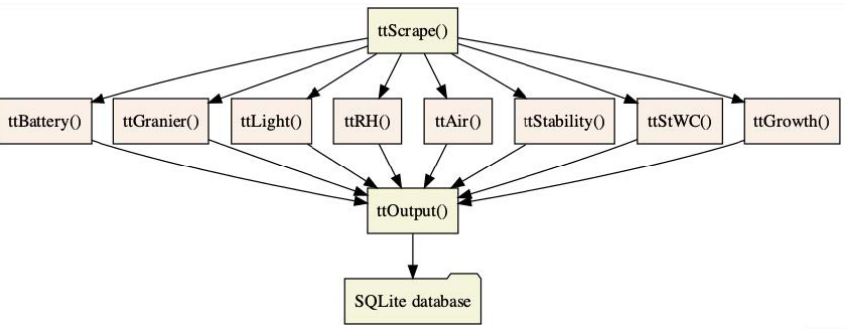
Figure 3. Detailed structure and functions of the ttalkR package. I/O functions are highlighted in green.